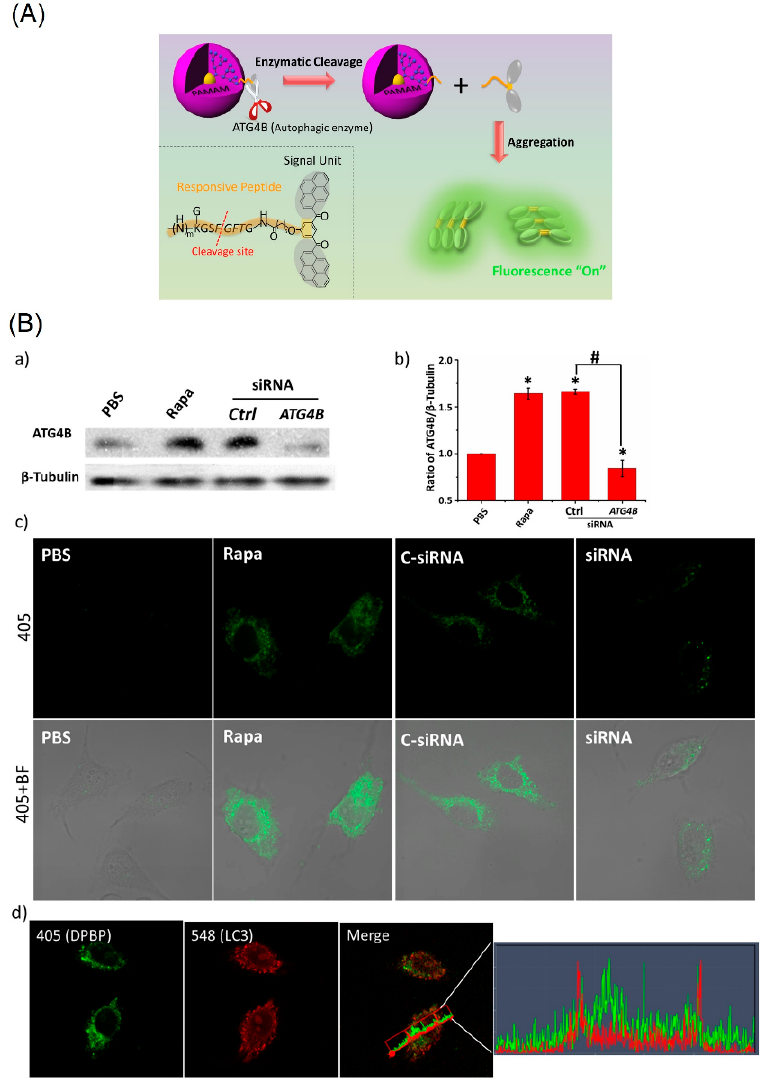
Figure 7. ( A ) Schematic illustration of DPBP as a bioprobe for autophagy detection. ( B ) Analyzing the specificity of DPBP to ATG4B in living cells. ( a ) Western blot of ATG4B expression in MCF-7 cells. ( b ) Quantitative analysis of band intensity of ATG4B from ( a ). ( c ) ATG4B activity was detected by DPBP in MCF-7 cells. MCF-7 cells were treated with 10 µL of PBS in a regular culture medium (lane 1); 10 µL Rapa (1.0 µM) (lane 2); transfection of a control siRNA (lane 3); and transfection of a siRNA against ATG4B (lane 4), followed by DPBP (100 µg/mL) for 2 h. ( d ) Correlation plot of DPBP and LC3. An overlap coefficient of 0.46 (0: no colocalization and 1: all pixels colocalized) confirmed that the BP spots from DPBP did not colocalize with LC3. Statistical significance: * p < 0.05 and # p < 0.05, one-way ANOVA for indicated comparison. 405: λ ex = 405 nm, λ em = 525 ± 50 nm; BF: bright field. (Reproduced with the permission from Ref. [74]).